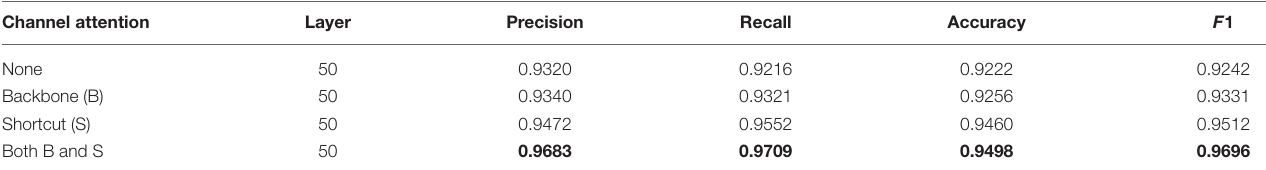
TABLE 4 | The experimental results of the ablation analysis of channel attention, the higher the values of precision, recall, accuracy, and F 1, the better the recognition performance. Channel